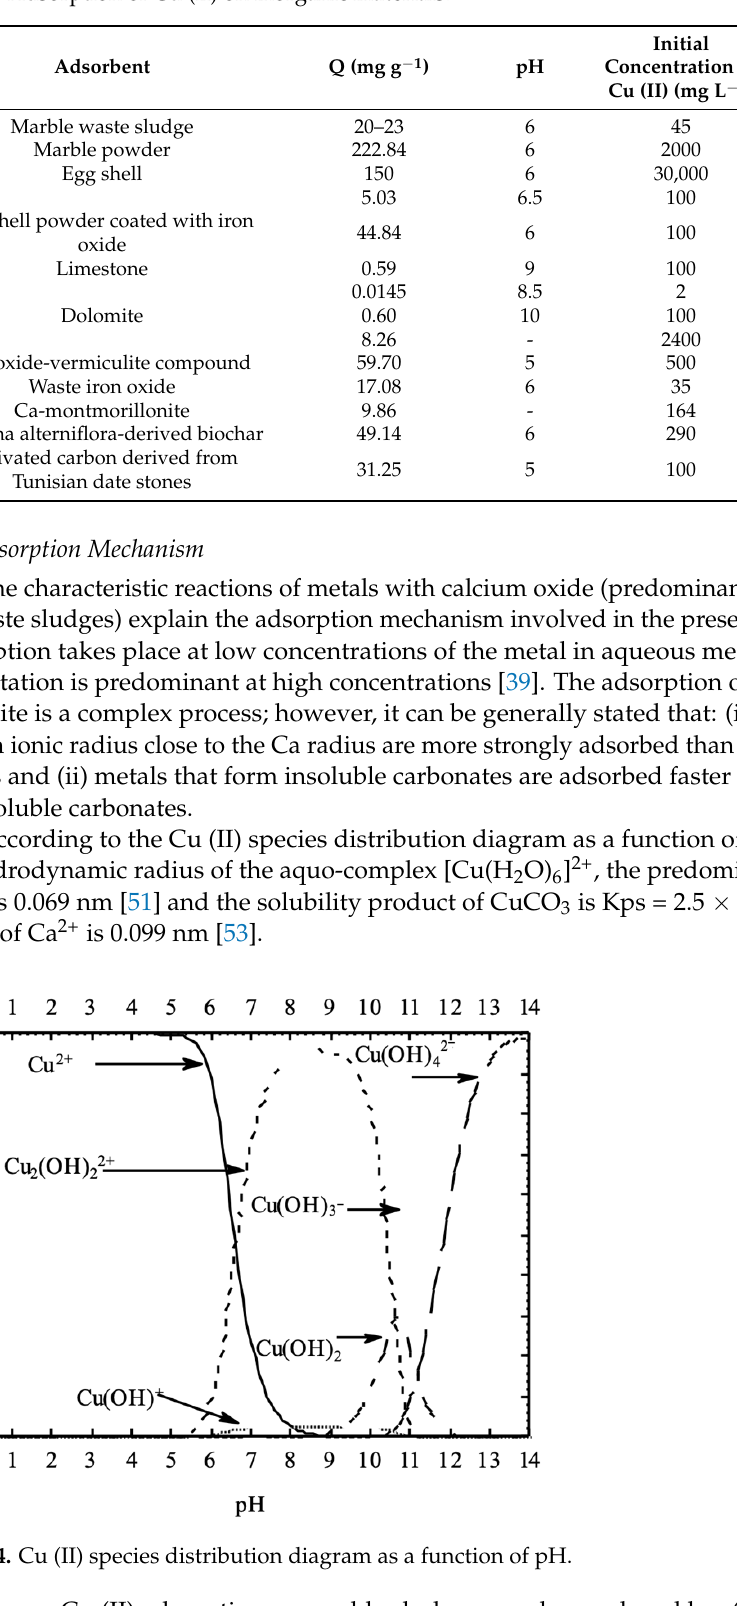
Table 5. Adsorption of Cu (II) on inorganic materials.